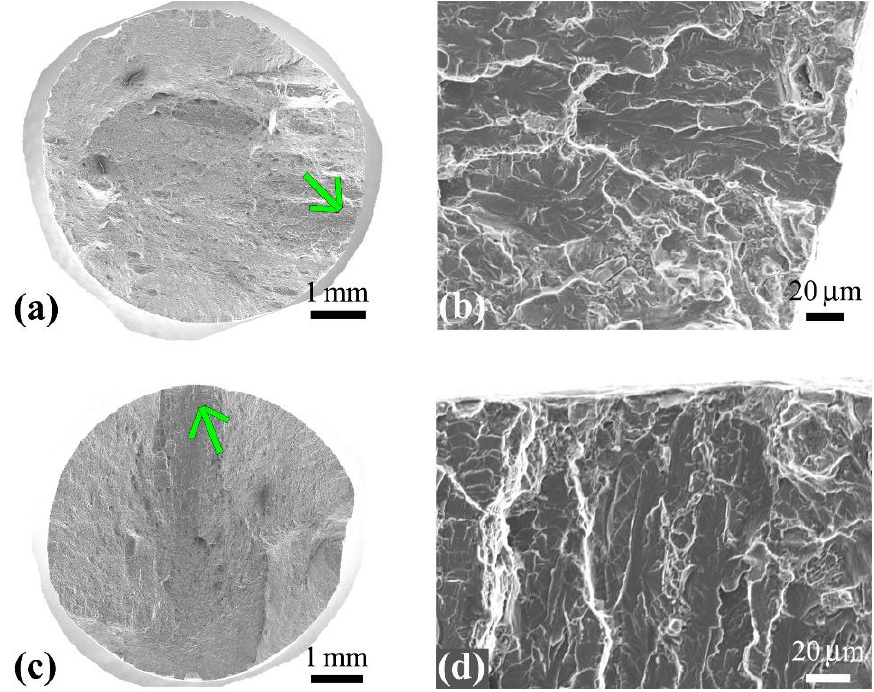
Figure 8. Morphologies of fracture surface of failed specimens at σ max = 815 MPa and d t ,max = 120 s under dwell fatigue testing. ( a , b ): Smooth specimen with N f = 1724 cycles; ( c , d ): Defective specimen with N f = 1066 cycles. ( b , d ) are magnified images of the regions where the arrows point to in ( a , c ), respectively.